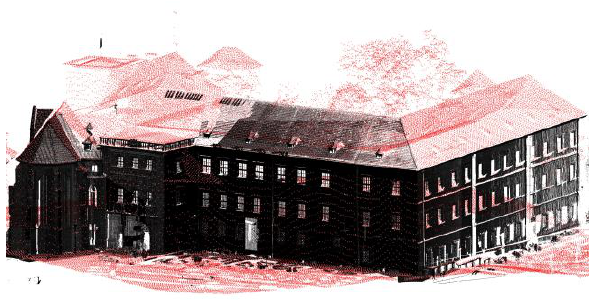
Figure 2. Example of the combined point cloud (part) of terrestrial (black) and airborne (red) laser scanning